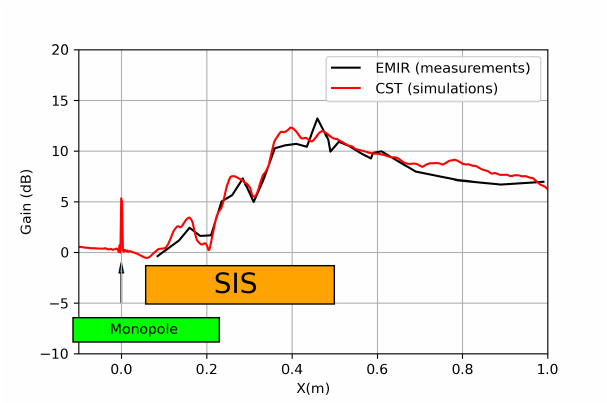
FIGURE 8. Simulated and measured gain at 1.1 GHz along a line lying in the horizontal plane (near field raised 3 cm above the ground plane)